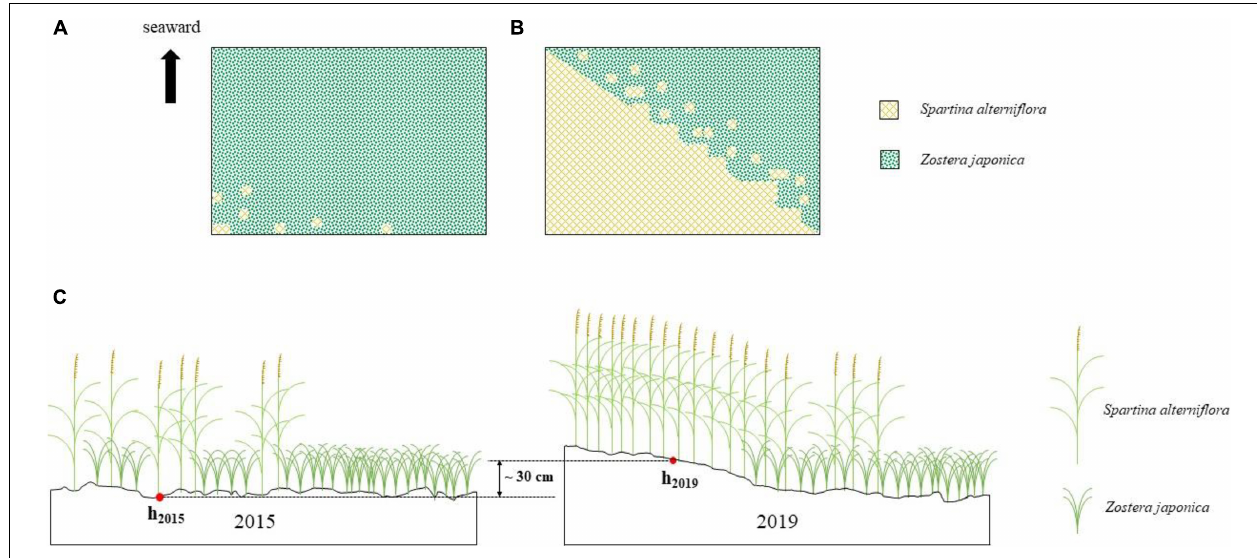
FIGURE 2 | Spartina alterniflora invasion of Zostera japonica meadows [ (A) 2015; (B) 2019] and the sediment accretion in the study region (C) .